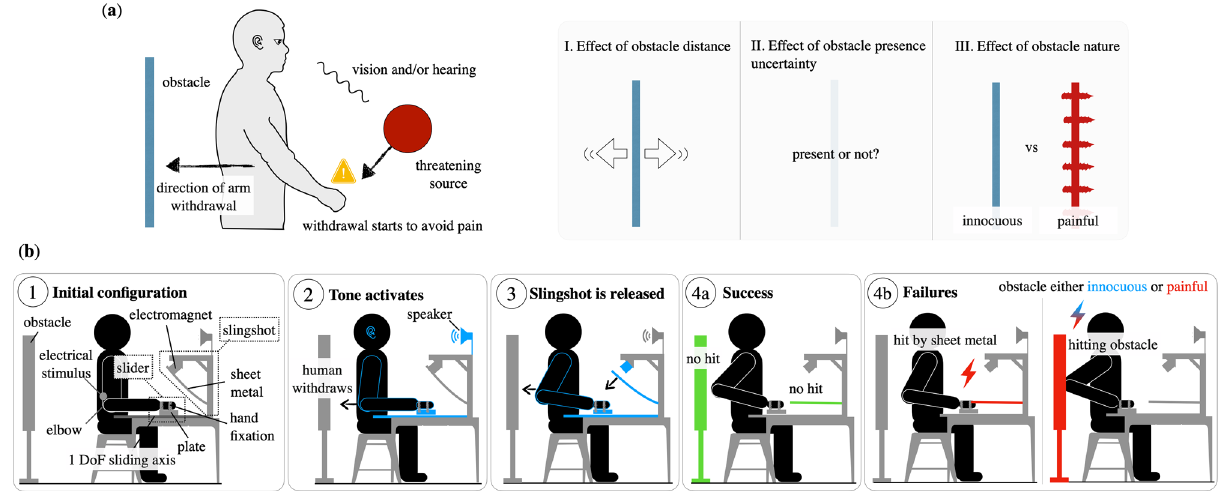
Figure 1. ( a ) Scenario under study. ( b ) Sketch of experimental setup and